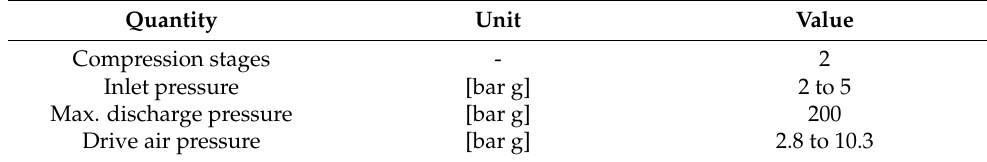
Table 5. Technical data of the air driven hydrogen compressor (booster)